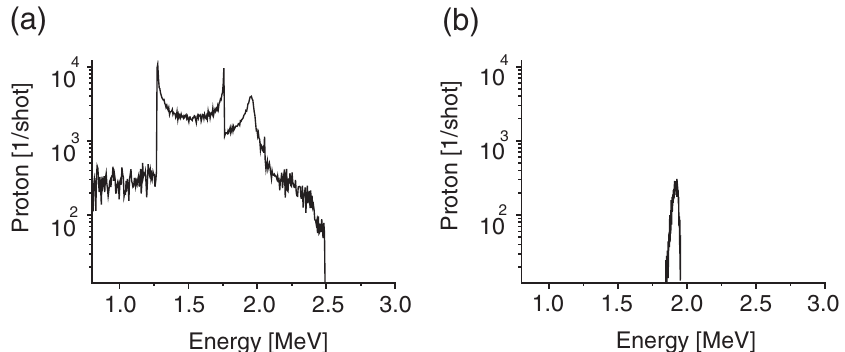
MEASURED AND SIMULATED TRANSPORT OF . .